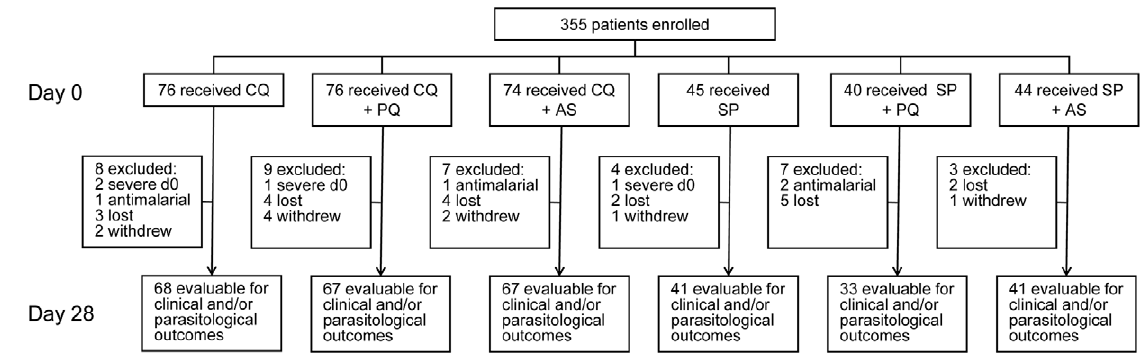
Figure 1. Trial profile. doi:10.1371/journal.pone.0028957.g001 PLoS ONE |